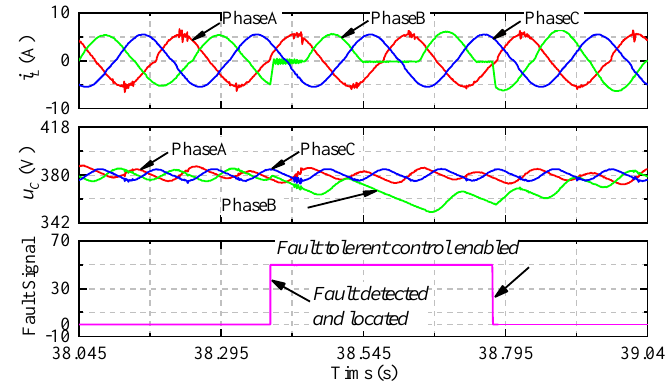
Figure 17. Signals collected by the host computer.